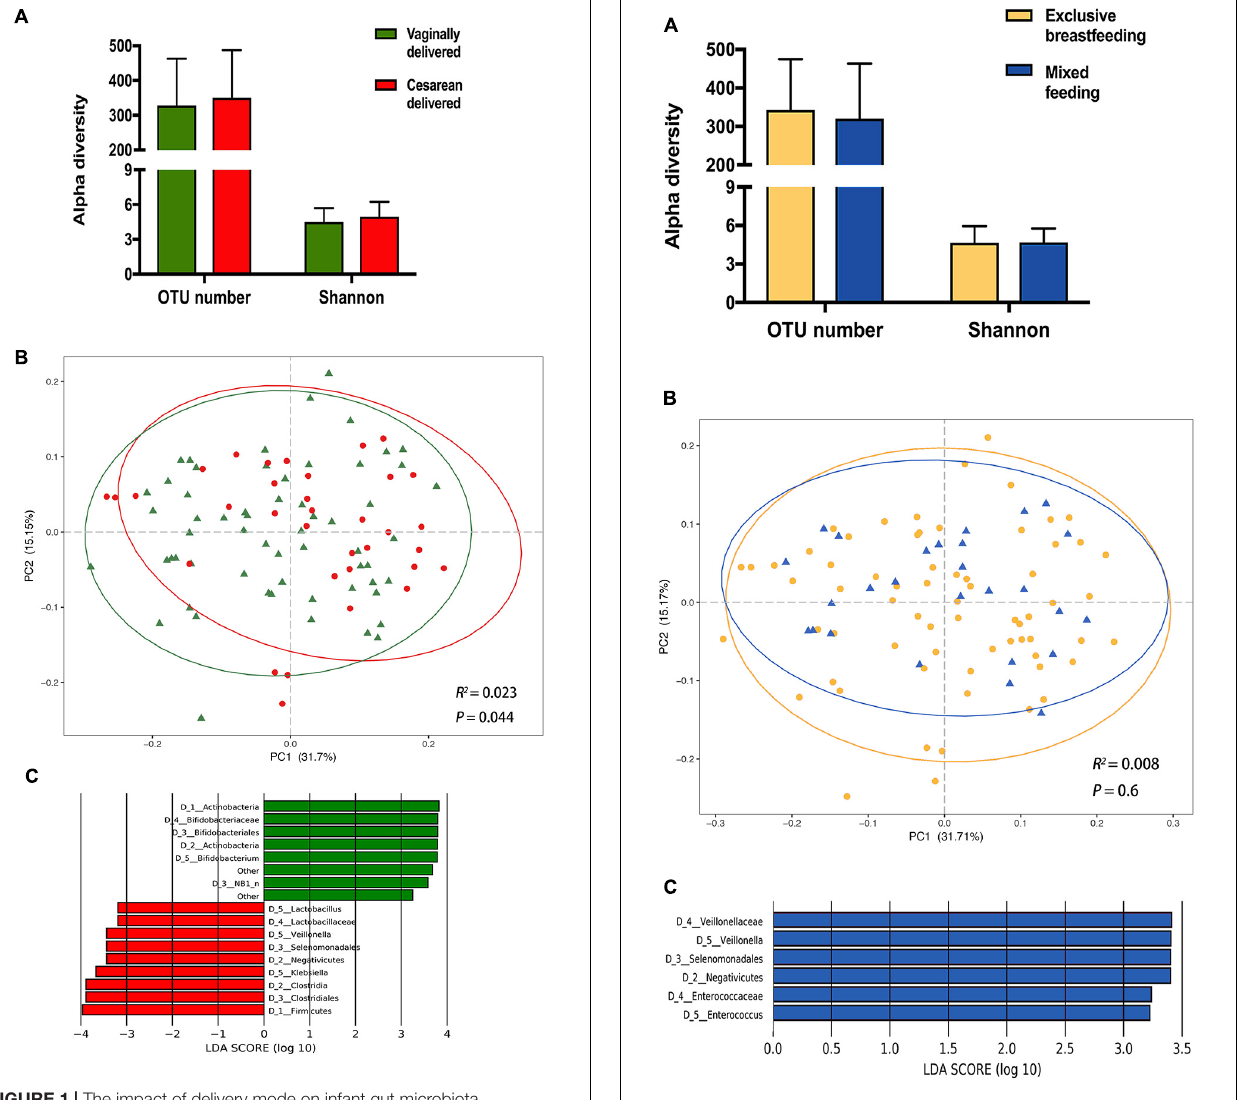
FIGURE 2 | The impact of feeding pattern on the infant gut microbiota. (A) Comparison of alpha diversity between exclusively breastfed and mixed-fed infants. (B) Principal coordinates analysis (PCoA) based on weighted UniFrac distances is shown along the first two principal coordinate (PC) axes with Adonis p -value. Percentages are the percent variation explained by each PC axis. Individual samples are represented by yellow points (exclusively breastfed) and blue triangles (mixed-fed). (C) Enriched taxa of different level from mixed-fed infants with a positive linear discriminant analysis (LDA) score are shown in blue (cut off value >